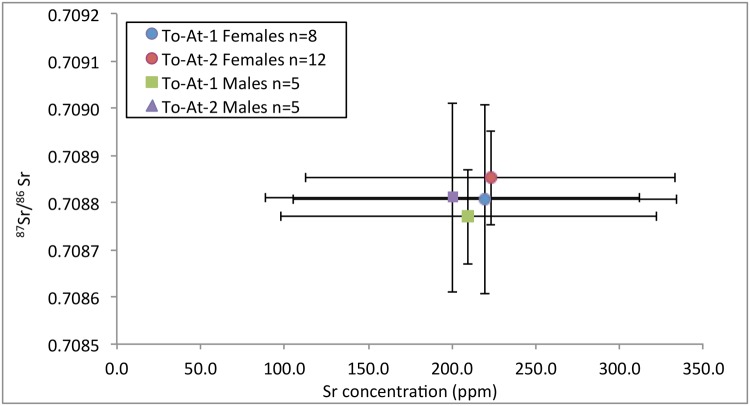
Mean (± 1SD) 87Sr/86Sr ratios for sex and burial mound.